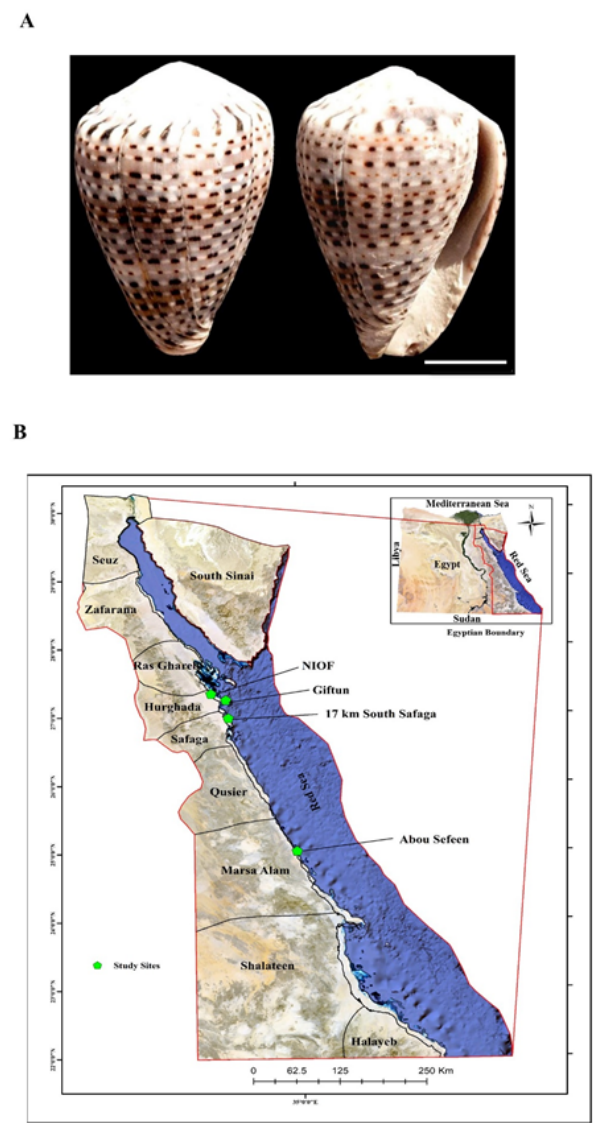
Figure 1. (A) General morphology of C. taeniatus shell (bar = 1 cm) and (B) map of the Red Sea in Egypt showing the collection sites of C. taeniatus